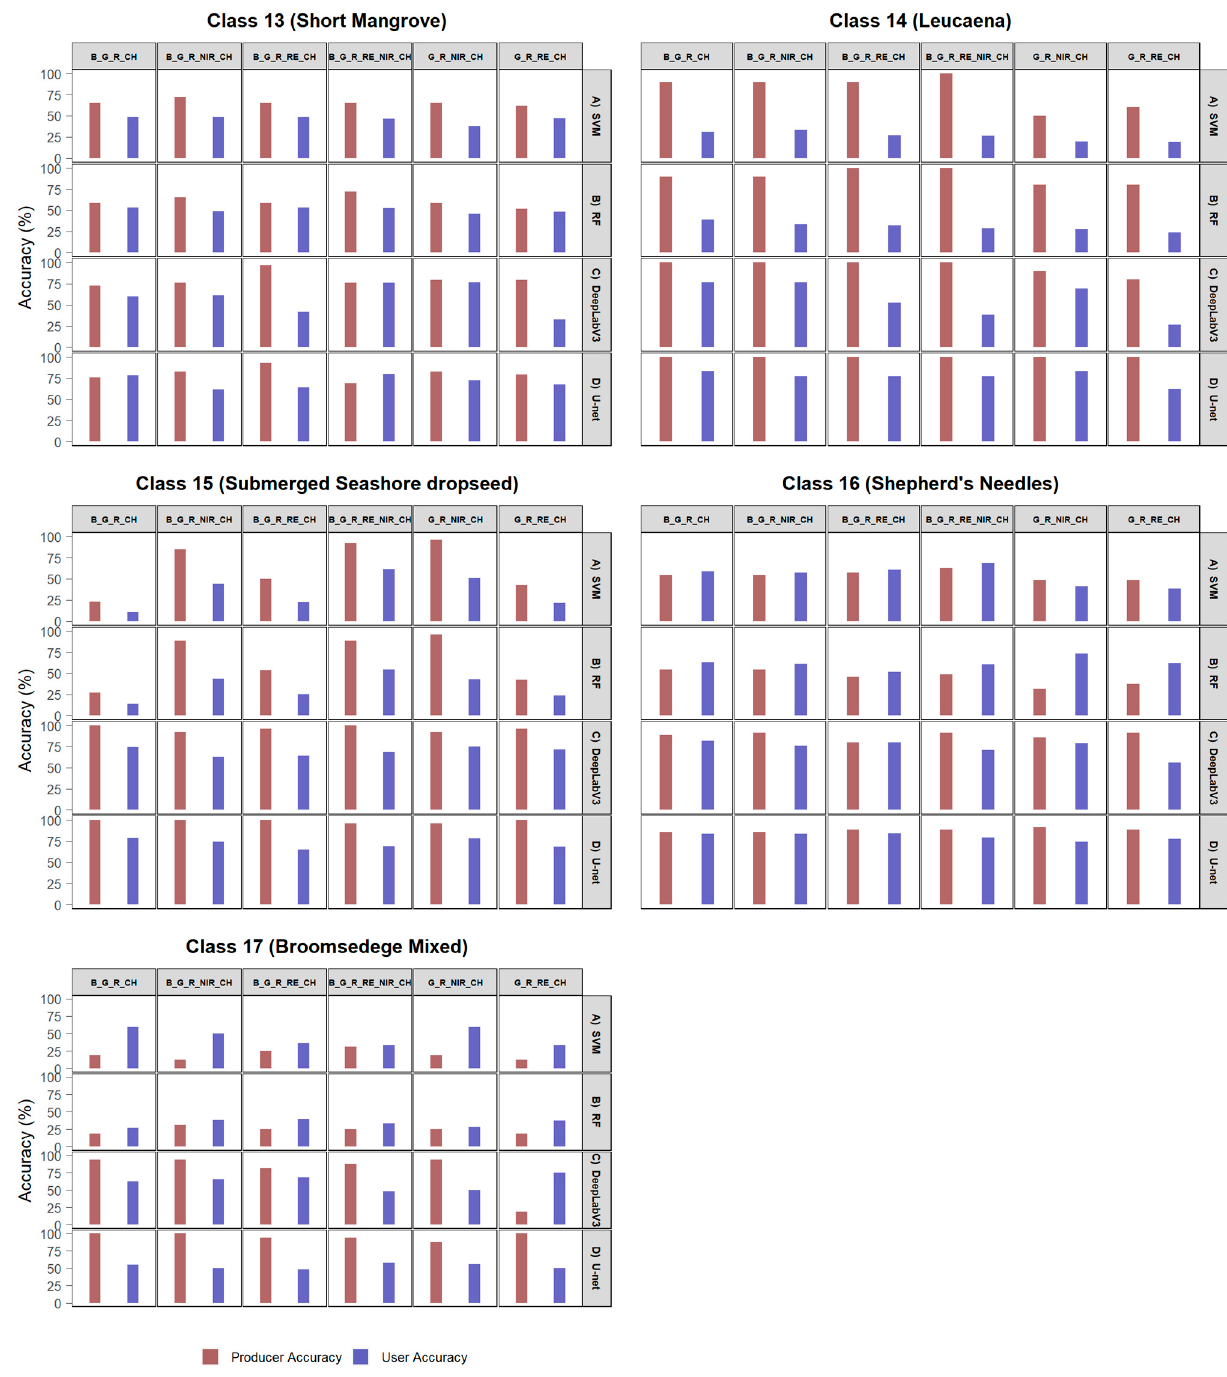
Figure A9. Experiment: EXP3-SB_ UAS_CHM, producer and user accuracy organized by class and classification method., classes 13 to 17.